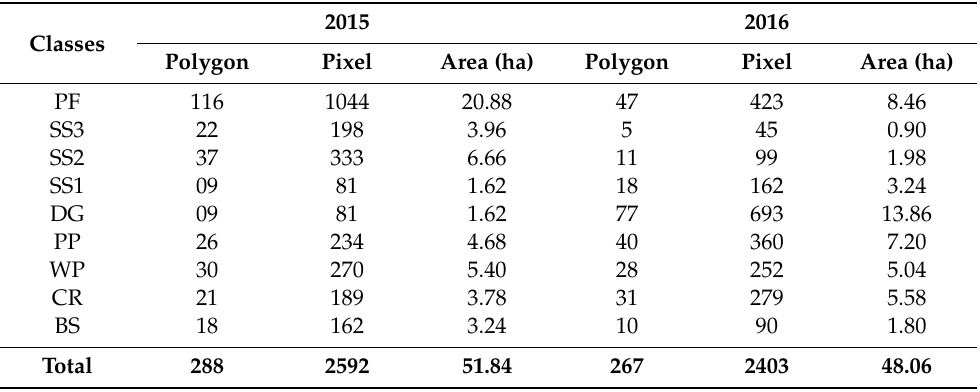
Table 4. Number of polygons, pixels, and corresponding areas per land use and land cover (LULC) class that was considered in Random Forest and Support Vector Machine classification processes involving ALOS / PALSAR-2 images from 2015 and 2016. For LULC class identification, see Table